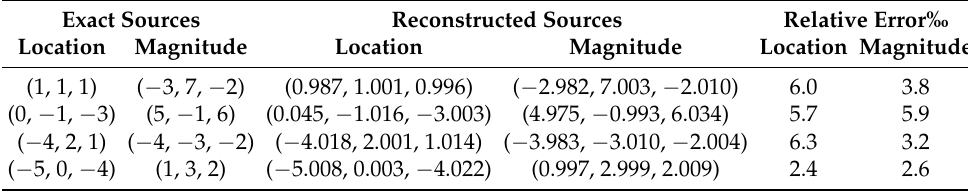
Table 3. Reconstruction of four single sources from far-field data in